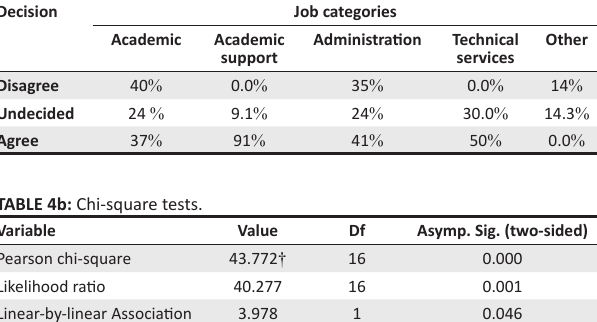
TABLE 4a: Cross-tabulations between ‘administrative and academic staff work collectively’ and job categories. Decision